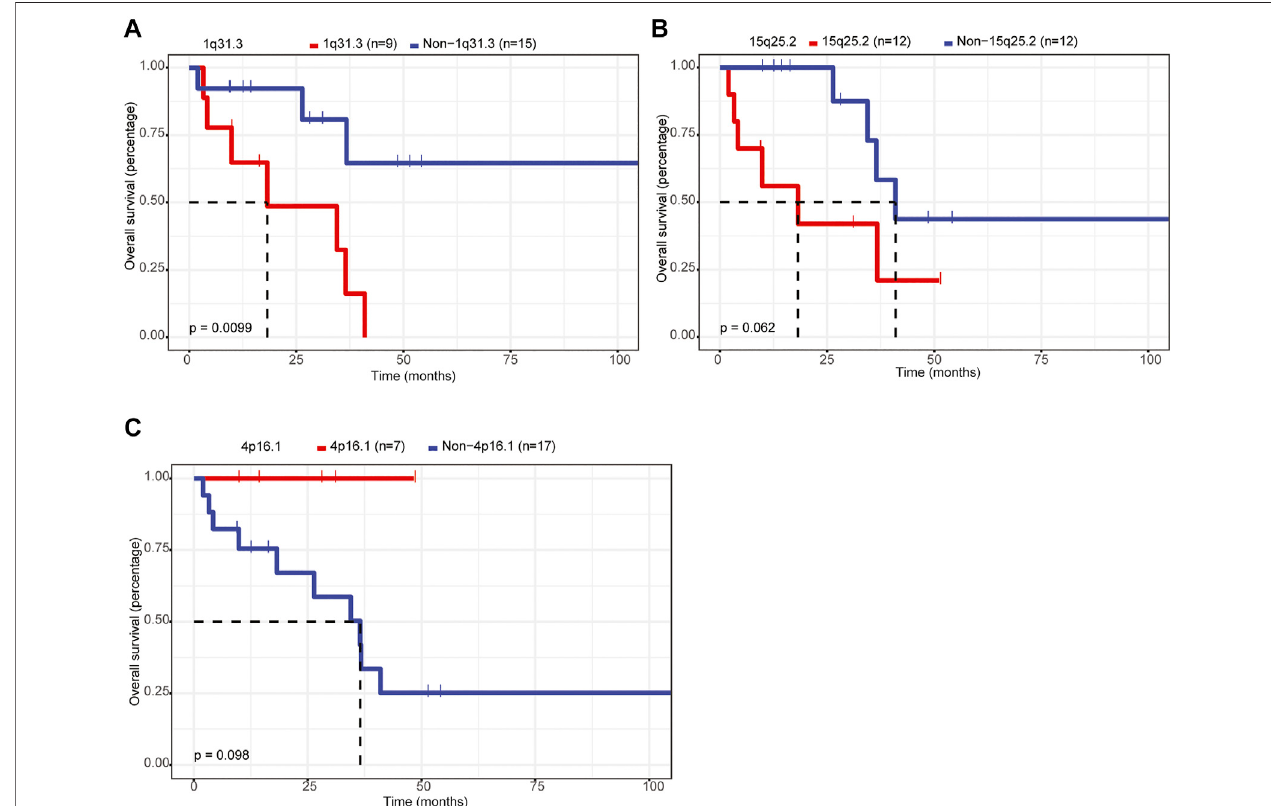
FIGURE6| AssessmentoftherelationshipbetweenCNVsandOSinpatientswithprimaryCNSDLBCL. (A – C) K-ManalysisoftherelationshipbetweentheCNVs (1q31.3 ampli fi cation, 15q25.2 deletion, 4p16.1 deletion) and the OS of patients with primary CNS DLBCL.